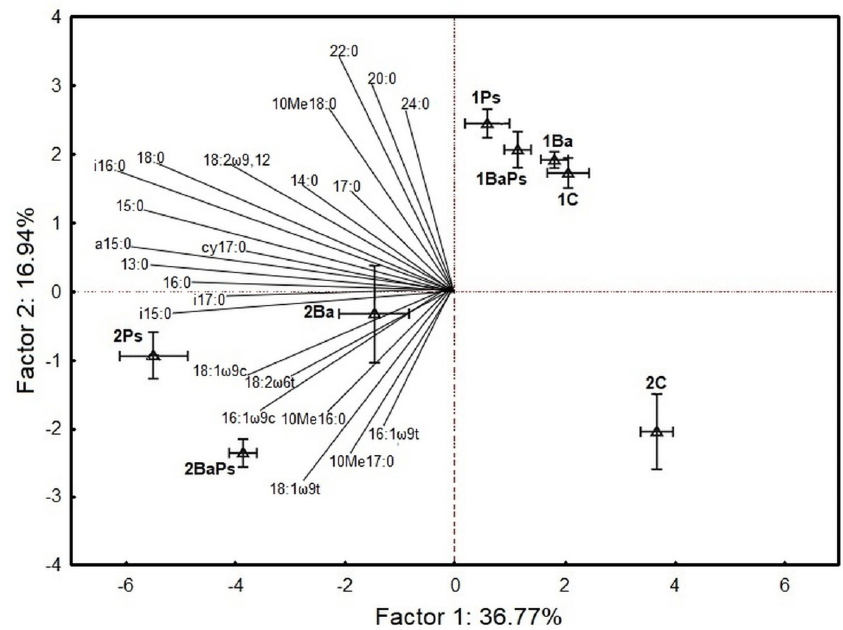
Figure 5. Ordination of the soil samples and the phospholipid (PLFA) biomarkers on a principal component analysis (PCA) biplot. Each point corresponds to the mean value of the loadings of the four samples belonging to the same treatment at the first and second axis (the first symbol corresponds to the management system (1: Conventional system (CS), 2: Organic system (OS)) and the second symbol corresponds to the inoculum treatment; Ba: B. subtilis ; Ps: P. fluorescens ; BaPs: Both inoculants; C: Control). Error bars indicate standard errors at both axes (n = 4).